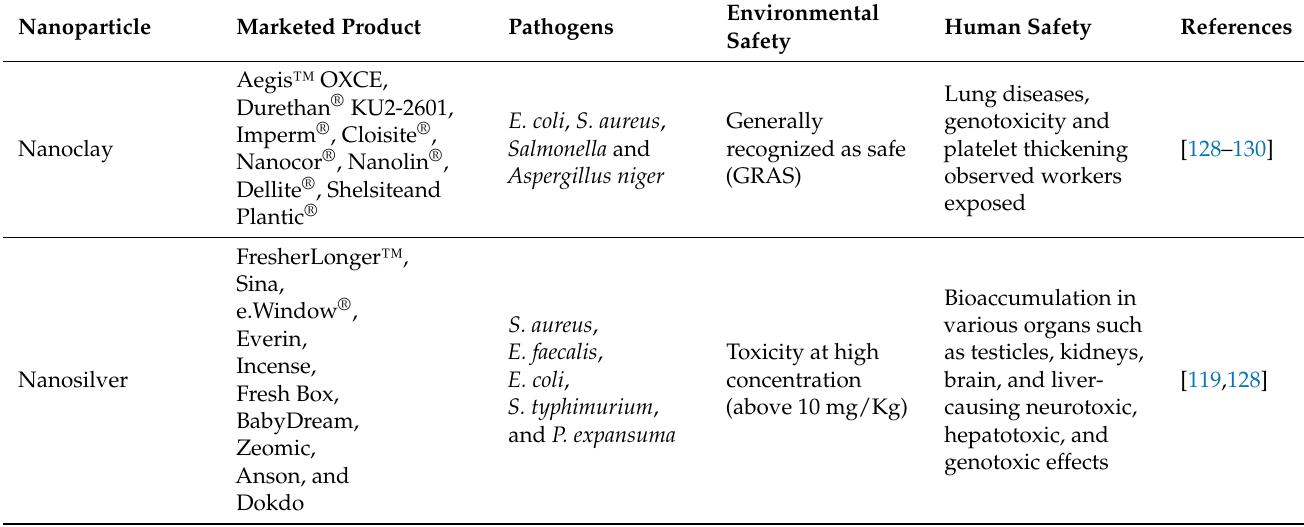
Table 4. Commercial products of nanoparticles in food packaging with their effect on pathogens, environment and human